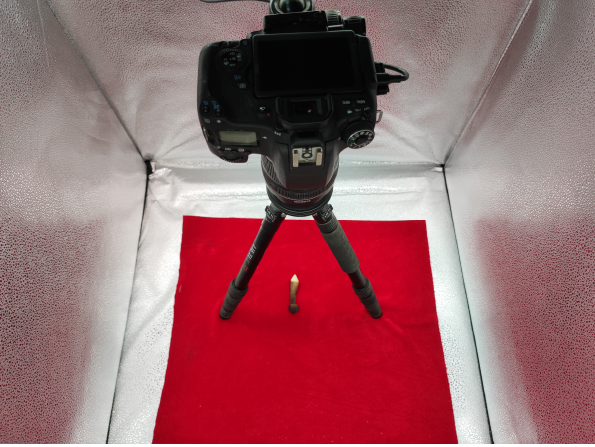
Figure 1. Experimental setup for image acquisition.